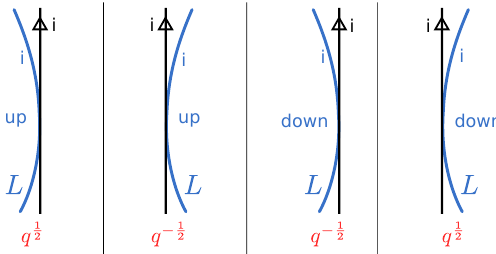
Figure 20 . Factors contributing to the winding factor q w ( e L ) . The notation is as in (cid:12)gure 17, namely \up" and \down" refer to the tangency of L in the x 3 -direction. The di(cid:11)erence from (cid:12)gure 17 is that here we use the orientation of the ij -leaf and ignore that of the projection of L , while in (cid:12)gure 17 we used the orientation of the projection of L and ignored that of the ij